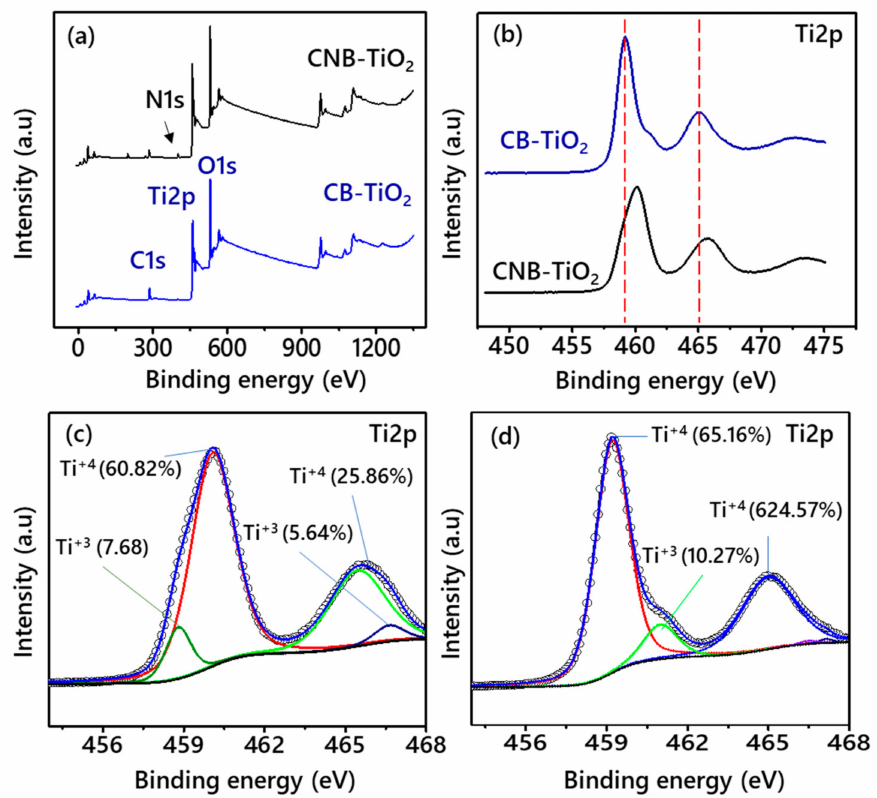
Figure 5. ( a ) XPS survey spectra and Ti2p XPS spectra ( b ) without deconvolution, and high resolution deconvoluted spectra of ( c ) CB-TiO 2 , and ( d ) CNB-TiO 2 . Table 2. XPS fitting parameters for CB-TiO 2 and CNB-TiO 2 nanomaterials. Binding Energy Fitting Parameters